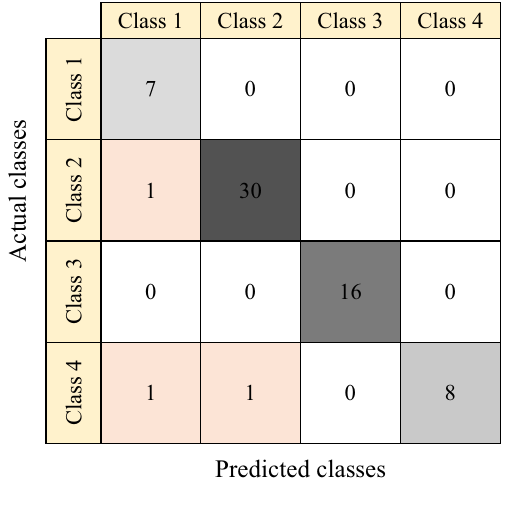
Fig. 15 Confusion matrix of LogitBoost algorithm applied to